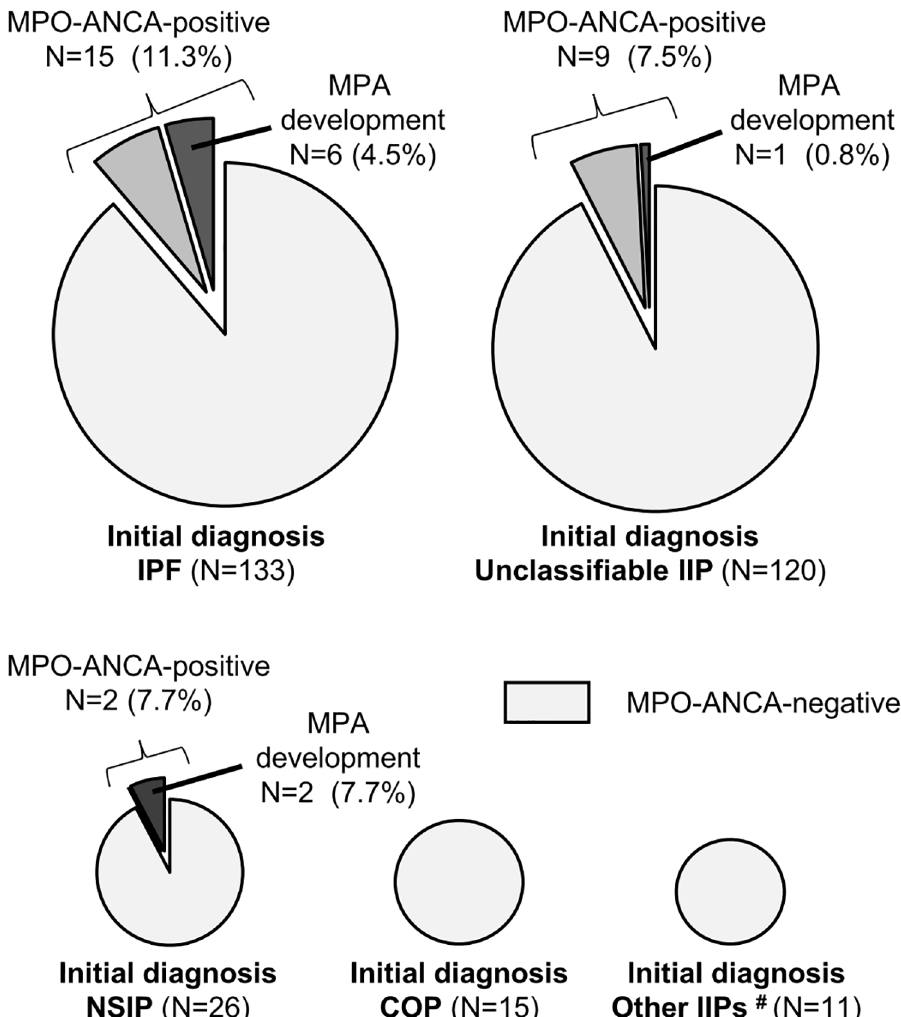
Fig 3. Frequencies of MPO-ANCA positivity and MPA development during the observation period in patients with the initial diagnoses of IPF, unclassifiable IIP, NSIP, COP and other IIPs (# AIP, n = 5; DIP/RB-ILD, n = 3; and PPFE, n = 3). AIP, acute interstitial pneumonia; COP, cryptogenic organizing pneumonia; DIP, desquamative interstitial pneumonia; IIPs, idiopathic interstitial pneumonias; IPF, idiopathic pulmonary fibrosis; MPA, microscopic polyangiitis; MPO-ANCA, myeloperoxidase-anti-neutrophil cytoplasmic antibody; NSIP, nonspecific interstitial pneumonia; PPFE, pleuroparenchymal fibroelastosis; RB-ILD, respiratory bronchiolitis-associated interstitial lung